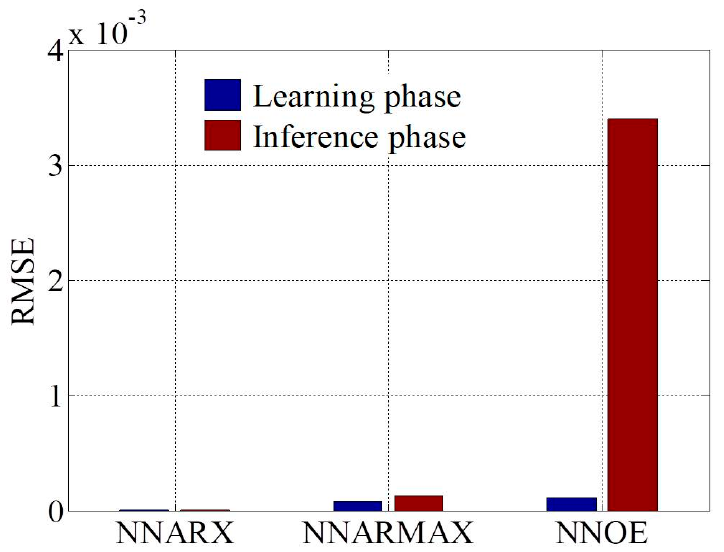
Figure 7. RMSE of the degradation prediction in the learning phase and inference phase.